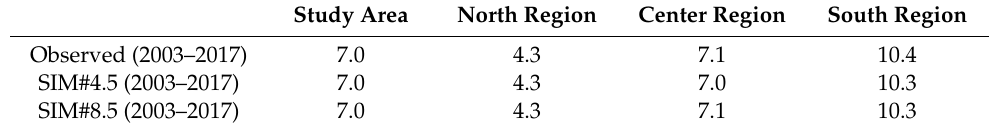
Table 4. Mean annual temperature [ ◦ C] based on spatially distributed observations and simulated climate.